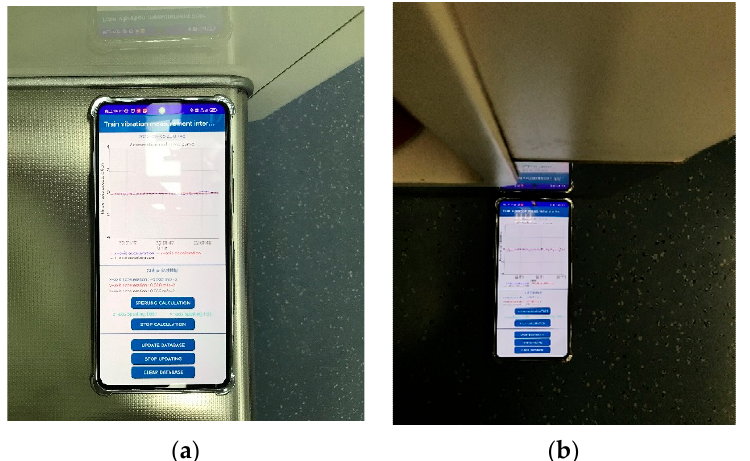
Figure 9. Application site of vibration measurement: ( a ) the mobile phone placed on the seat; ( b ) the mobile phone placed on the floor.